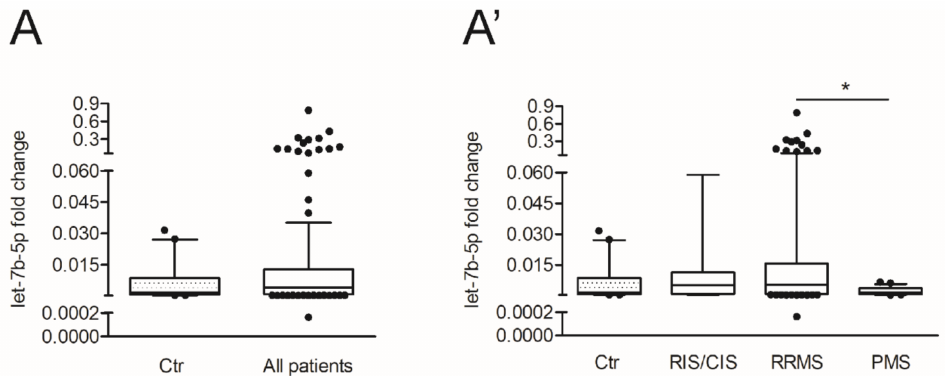
Figure 4. The levels of let-7b-5p are different according to diverse MS disease subtypes. ( A ) Box and whisker plots of let-7b-5p levels in the CSF, isolated from control subjects (Ctr) compared to all MS patients (Ctr, n = 20; All patients, n = 166; Mann-Whitney test, p > 0.05). ( A’ ) Box and whisker plots of let-7b-5p levels in the CSF isolated from control subjects compared to patients separated in CIS/RIS, RRMS and PMS patients (Ctr, n = 20; CIS/RIS, n= 25; RRMS, n = 117; PMS, n = 24; Kruskal-Wallis test, * p < 0.05 RRMS vs. PMS). Data were normalized to miR-204-5p expressed as 2 − ∆ Ct let7b-5p-miR-204-5p ). Values are median of 2 − ∆ Ct with 10–90% percentiles (error bars) and 25–75% percentiles (open boxes).